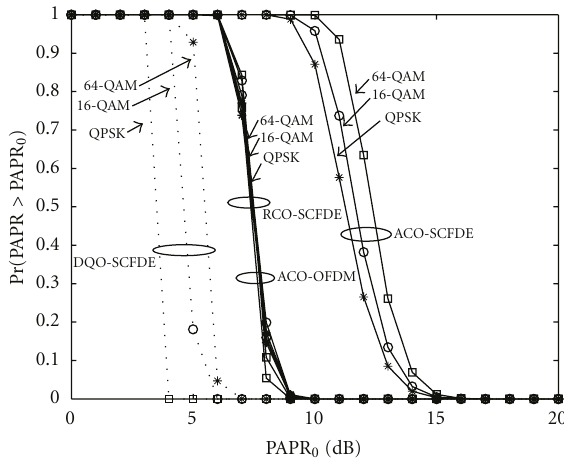
Figure 7: CCDF of PAPR comparison of ACO-OFDM, ACO- SCFDE, RCO-SCFDE, and